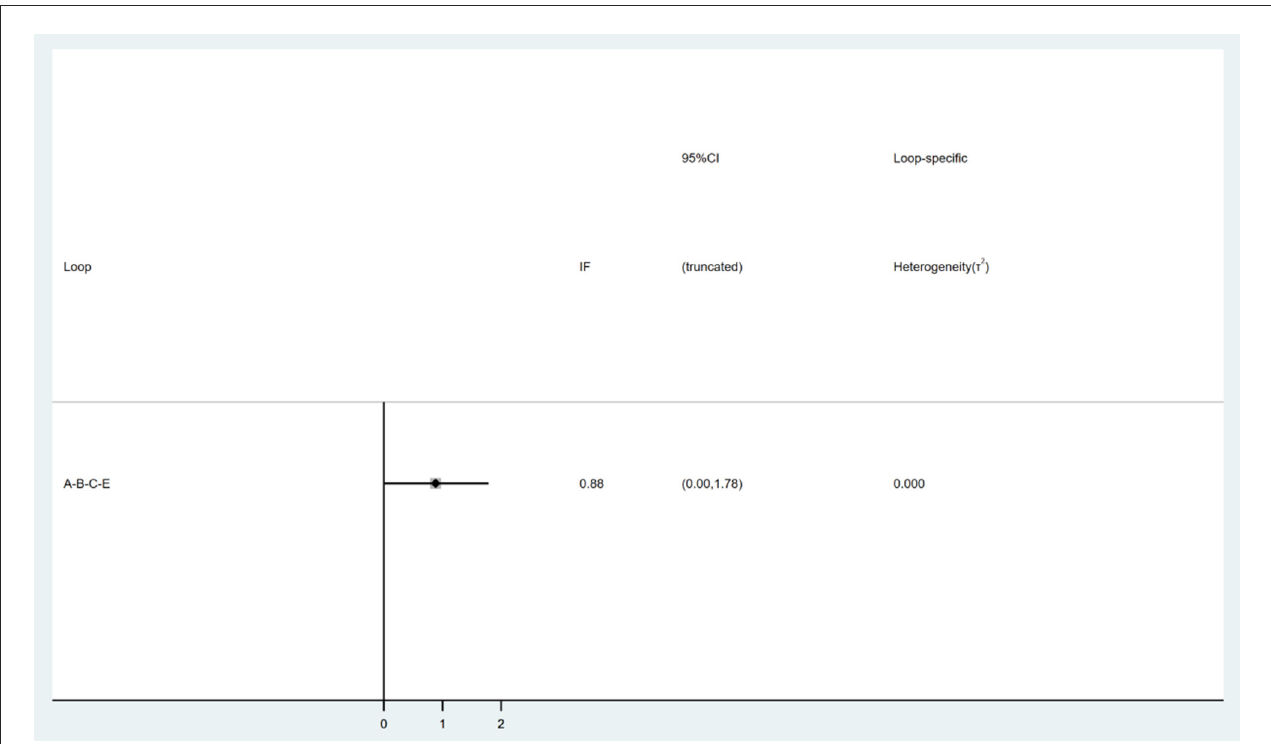
FIGURE5 Consistency test. A, CT; B, sham; C, 2min + 1mA anodal; E, 20min + 1.2mA